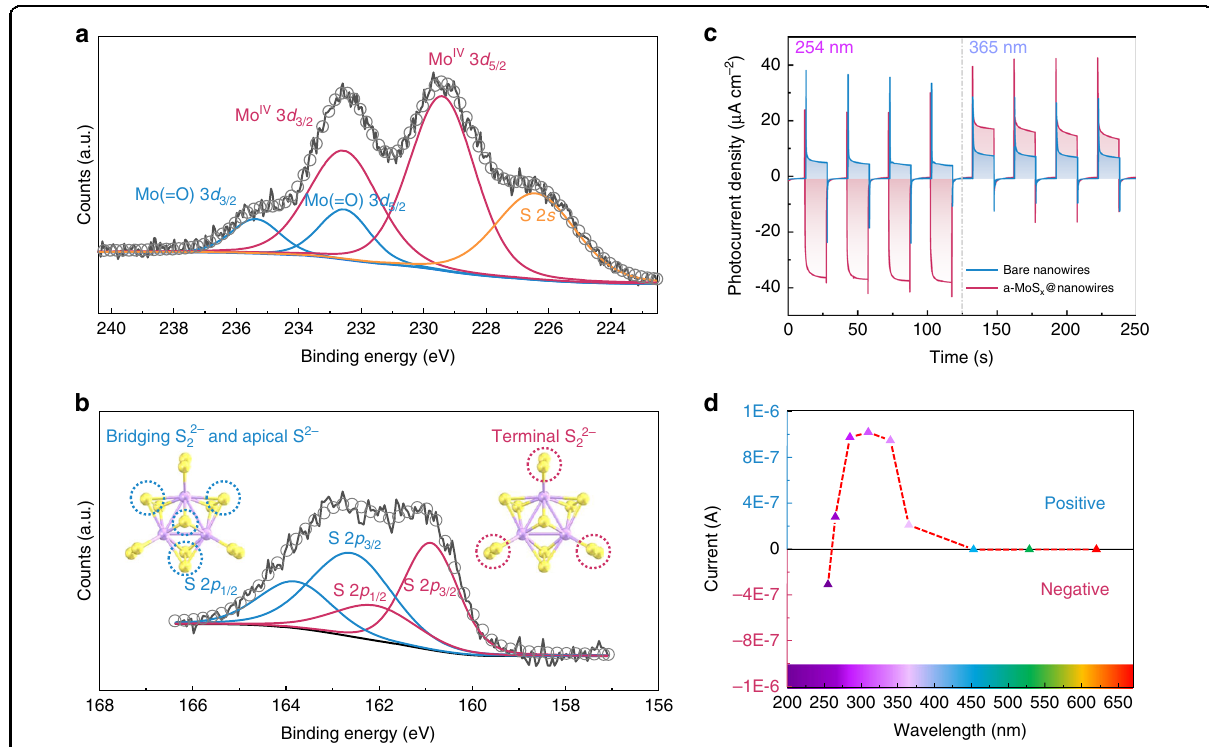
Fig. 3 Chemical composition and photoresponse behavior. a , b XPS core-level spectrum and fi tted peaks of S and Mo for a fresh a-MoS x decorated p-AlGaN/n-GaN nanowires. c Photoresponse of the bare p-AlGaN/n-GaN nanowires (blue curves) and MoS x -decorated p-AlGaN/n-GaN nanowires (red curves) in 0.5 M H 2 SO 4 with UV illumination at a periodic interval of 15 s at 0 V (365 nm intensity = 0.65 mW cm − 2 , 254 nm intensity = 0.4 mW cm − 2 ). d Evolution of the current signal of a-MoS x @p-AlGaN/n-GaN nanowires in the wavelength range of 255 – 620